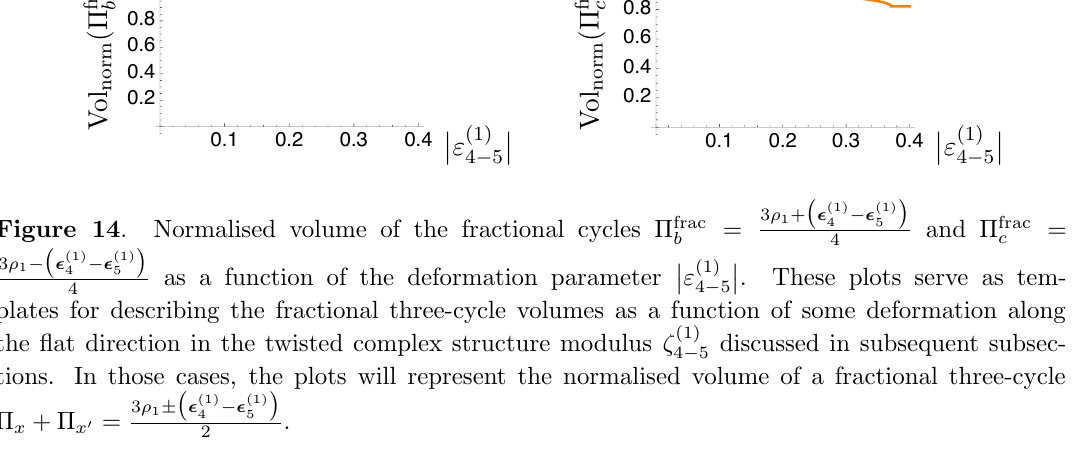
(cid:0) (cid:1) 3 (cid:26) 1 + (cid:15) (1) 4 (cid:0) (cid:15) (1) 5 = and (cid:5) frac = c b 4 (cid:12) (cid:12) (1) (cid:12) " (cid:12) . These plots serve as tem- 4 (cid:0) 5 discussed in subsequent subsec- 4 (cid:0) 5